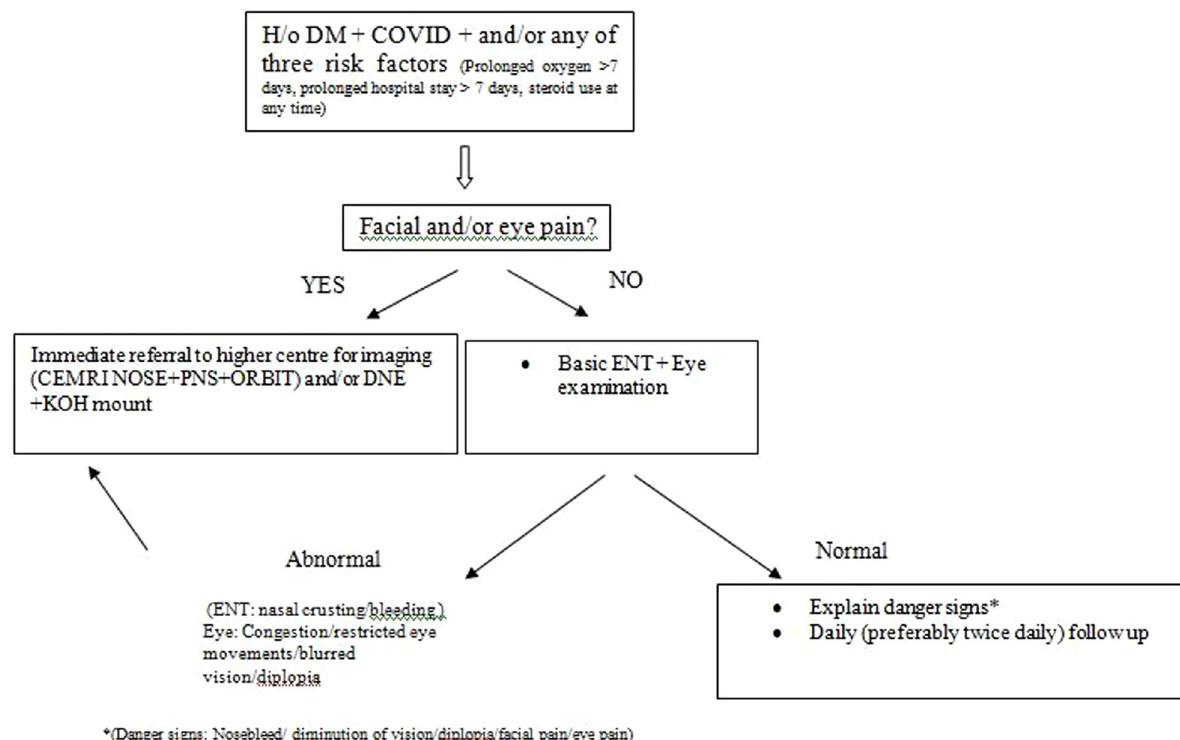
Fig. 3 Proposed screening protocol on basis of clinical signs and symptoms which can be used in peripheral areas/areas with limited medical facilities. If a patient with diabetes and COVID and/or any 3 risk factors (as per flowchart) presents to the clinic, and they have facial/eye pain, immediately refer to higher centre for imaging and endoscopy. If no facial/eye pain, perform ENT examination—if it is abnormal, viz. nasal crusting/ bleeding/eye symptoms—refer to higher centre as above; if ENT examination normal, explain danger signs and perform twice daily